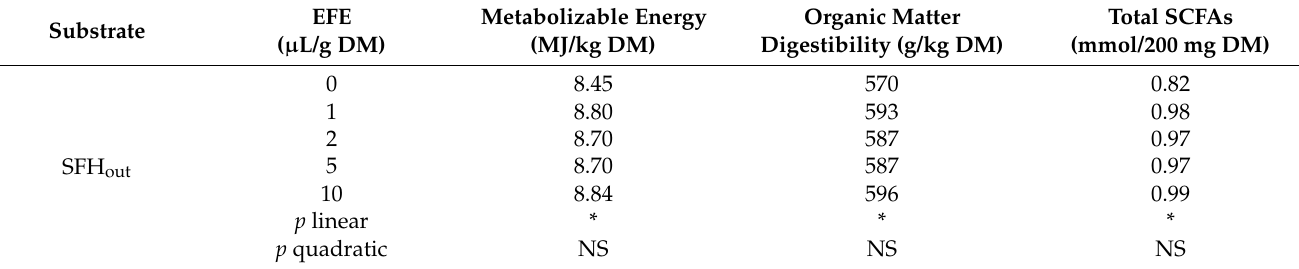
Table 6. Effects of EFE supplemented to pretreated SFH (SFH out , SFH NaOH , SFH urea ) on metabolizable energy, organic matter digestibility and ruminal total short chain fatty acids concentrations